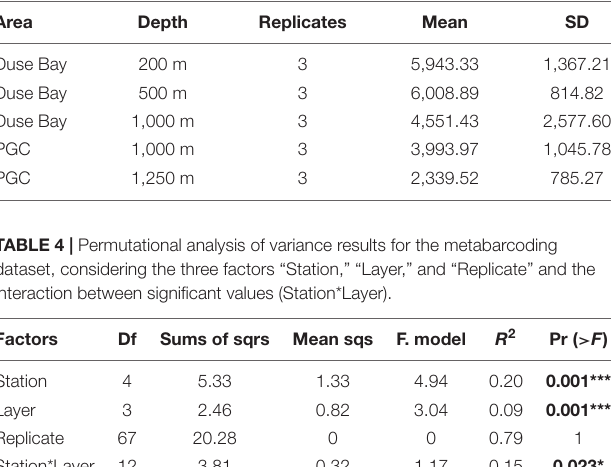
Frontiers in Marine Science |